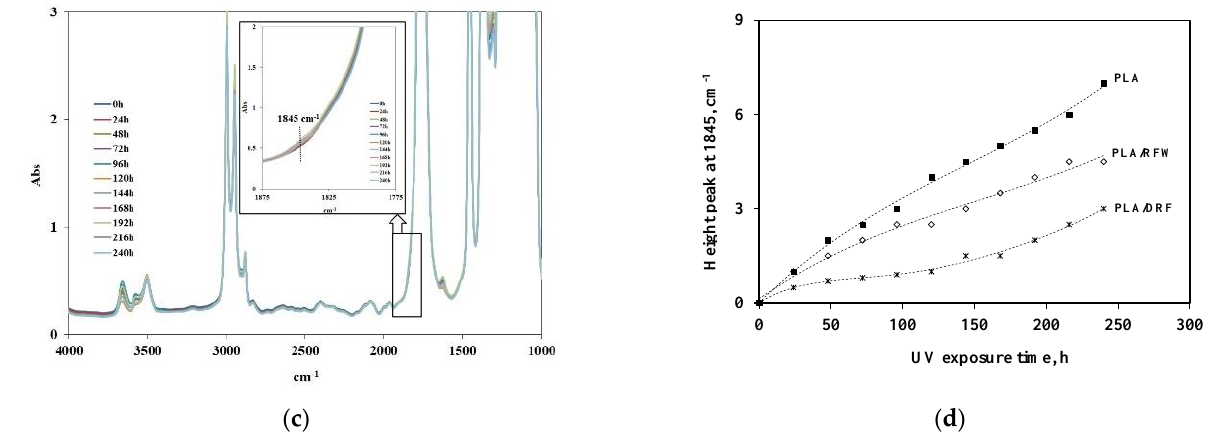
Figure 7. FTIR spectra of ( a ) PLA, ( b ) PLA/DRF, and ( c ) PLA/RFW at different photo-oxidation times. ( d ) Height peak at 1845 cm −1 for neat PLA and investigated composites as a function of the photo-oxidation times.